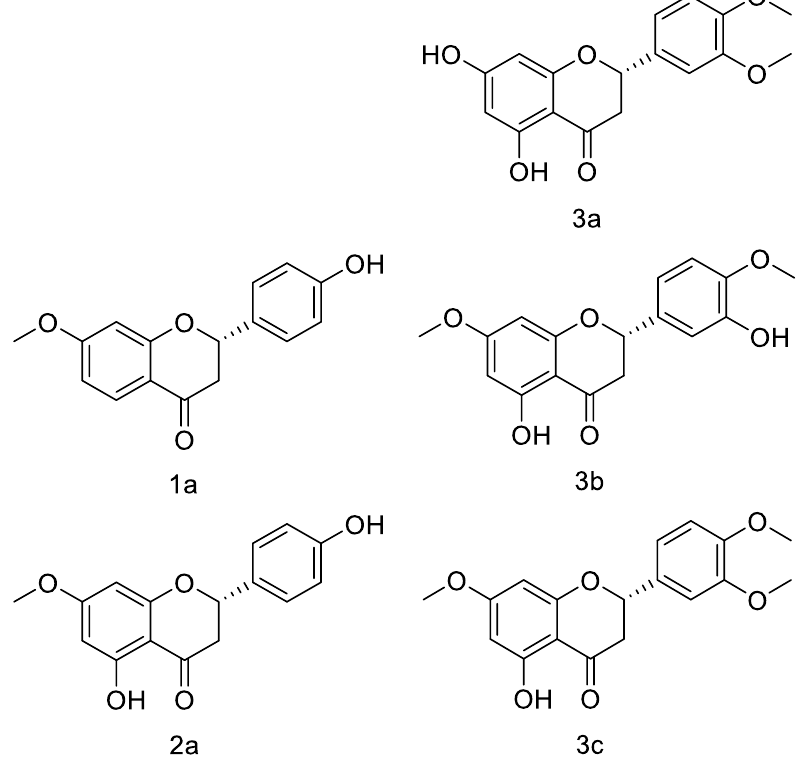
Figure 2. Structures of compounds 1a, 2a, 3a, 3b, and 3c, as identified by NMR. Table 2. 1 H (600 MHz) and 13 C NMR (150 MHz) data of 1a and 2a in DMSO- d 6.